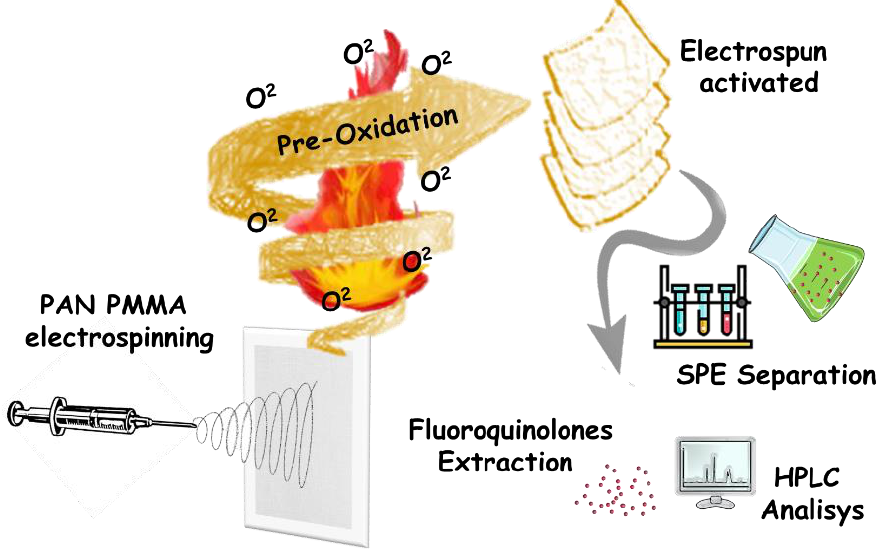
Figure 1. Graphical representation of the main steps of sample preparation.